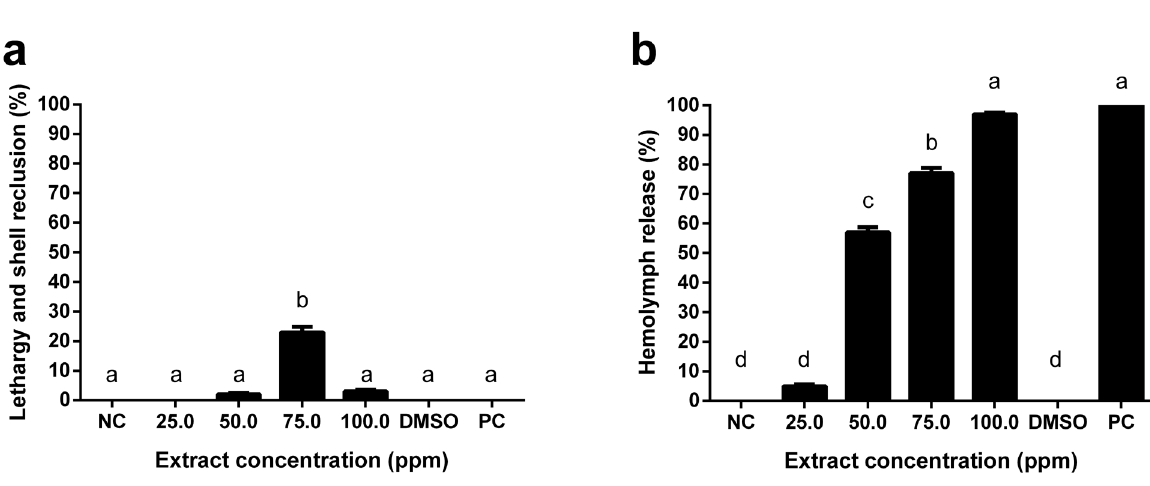
Figure 5. Frequency (%) of lethargy and shell reclusion ( a ) and hemolymph release ( b ) of the Biomphalaria glabrata adults after exposure to the ethanolic crude extract of the Persea americana stem bark for 96 h. Results are expressed as mean ± standard deviation. One-way ANOVA followed by Tukey’s multiple comparisons test. Different letters indicate differences between groups (p < 0.05). (NC) Negative control. (PC) Positive control (niclosamide); (DMSO) Dimethylsulfoxide – solvent